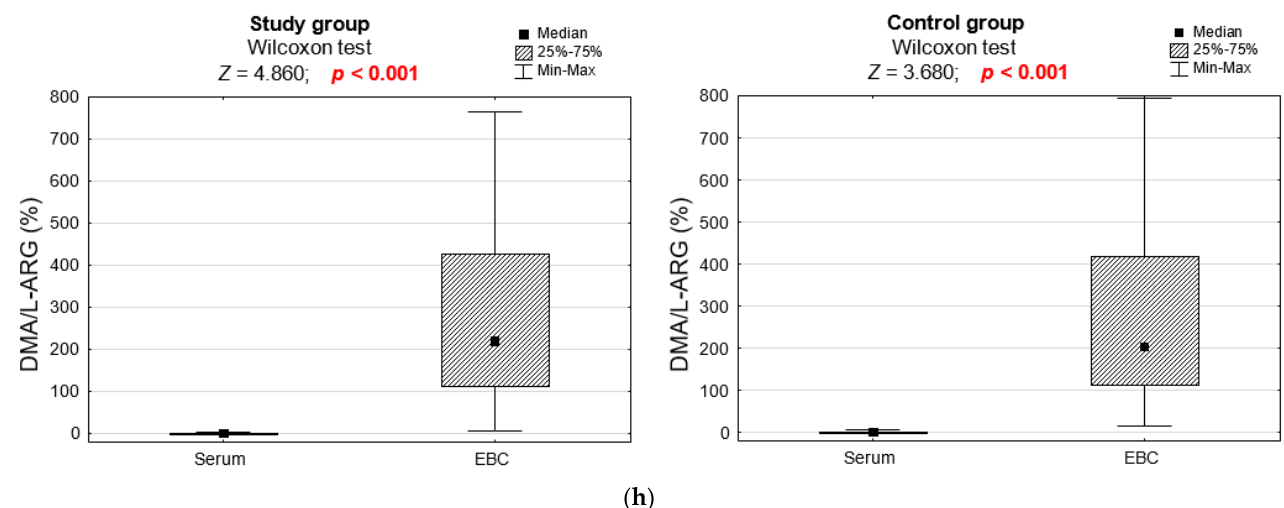
Table 6. Correlation of FEV1 and IL-4 in serum and EBC with L-ARG and its metabolites.